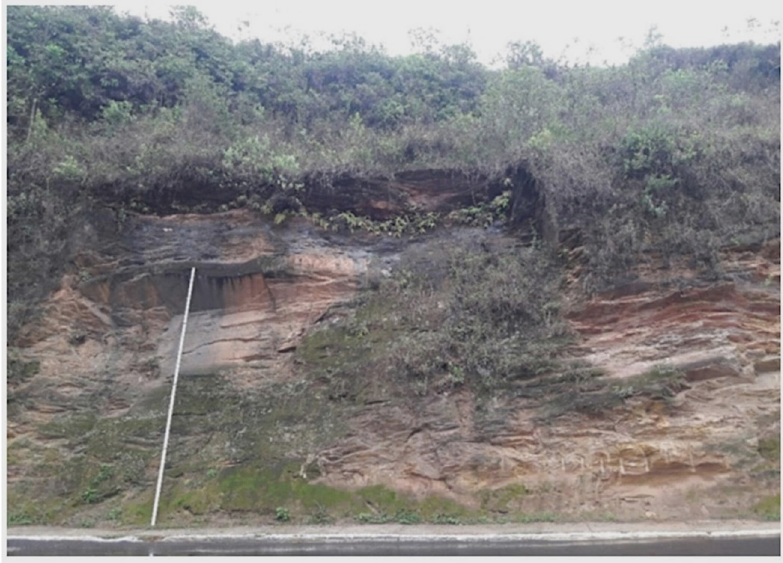
Figure 7. Slope ‐ 3.